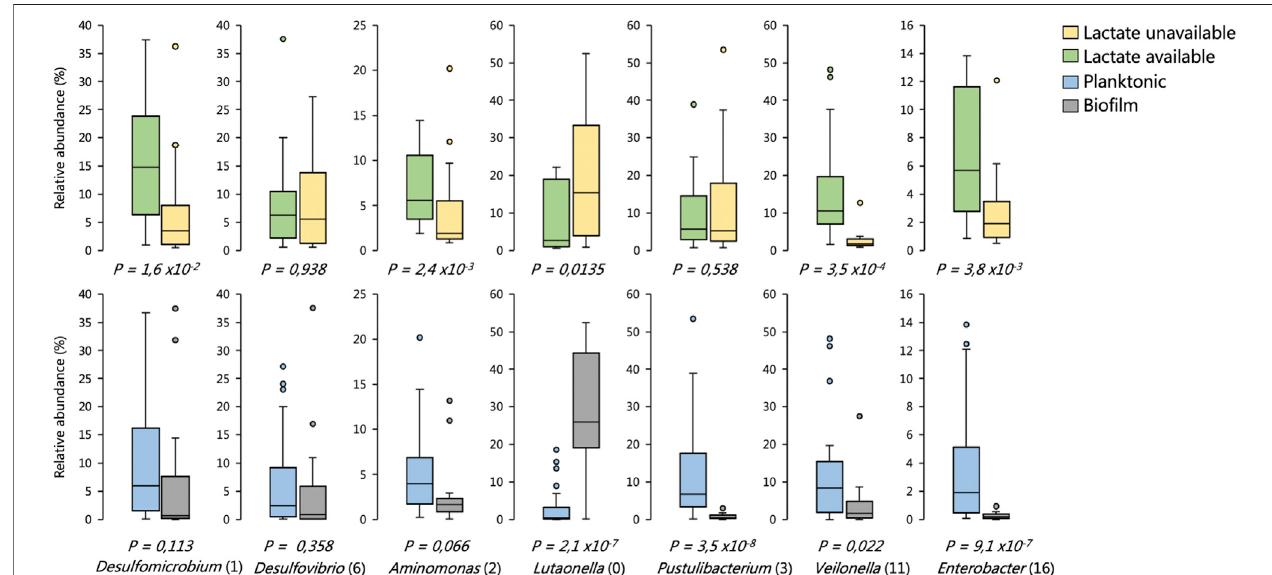
FIGURE 10 | Distribution in the abundance of frequently occurring OTUs across reactor environments of six BSR reactor systems, including environments where lactate was present versus unavailable, and bio fi lm versus planktonic environments. The box plots show the four interquartile ranges with the maximum and minimum calculated as the interquartile range multiplied by 1.5. Some of these data have been published previously (Hessler et al., 2018; Hessler et al., 2020). Statistical signi fi cance was determined by Welch ’ s test. Sample sizes are shown in Supplementary Table S9 .